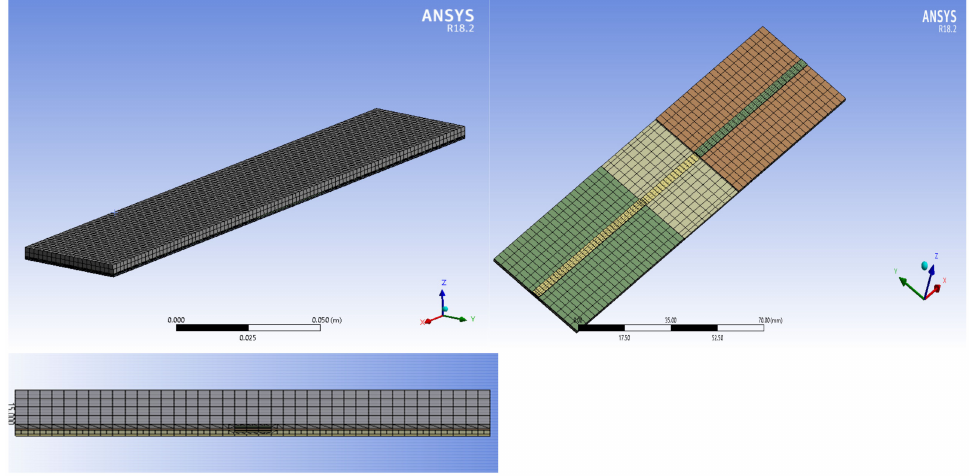
Figure 2. Meshed geometry of cell-to-cell interconnection.